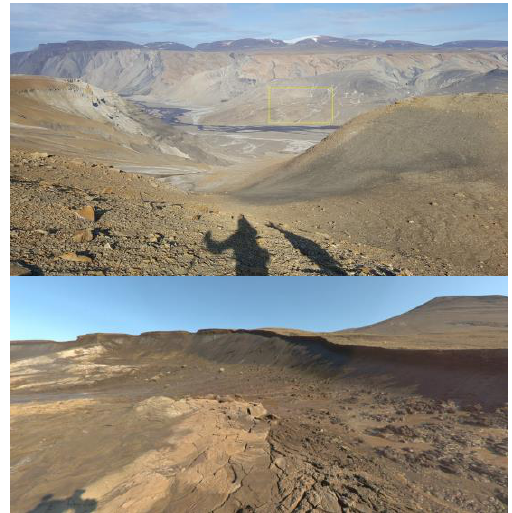
Figure 2. A: The thaw slump area is seen on the opposing slope across a valley (yellow). B: The outcrop of ice exposed by the thaw slump seen by Ladybug5+ camera. The smaller slump higher on the slope is also seen as a scar to the top right.